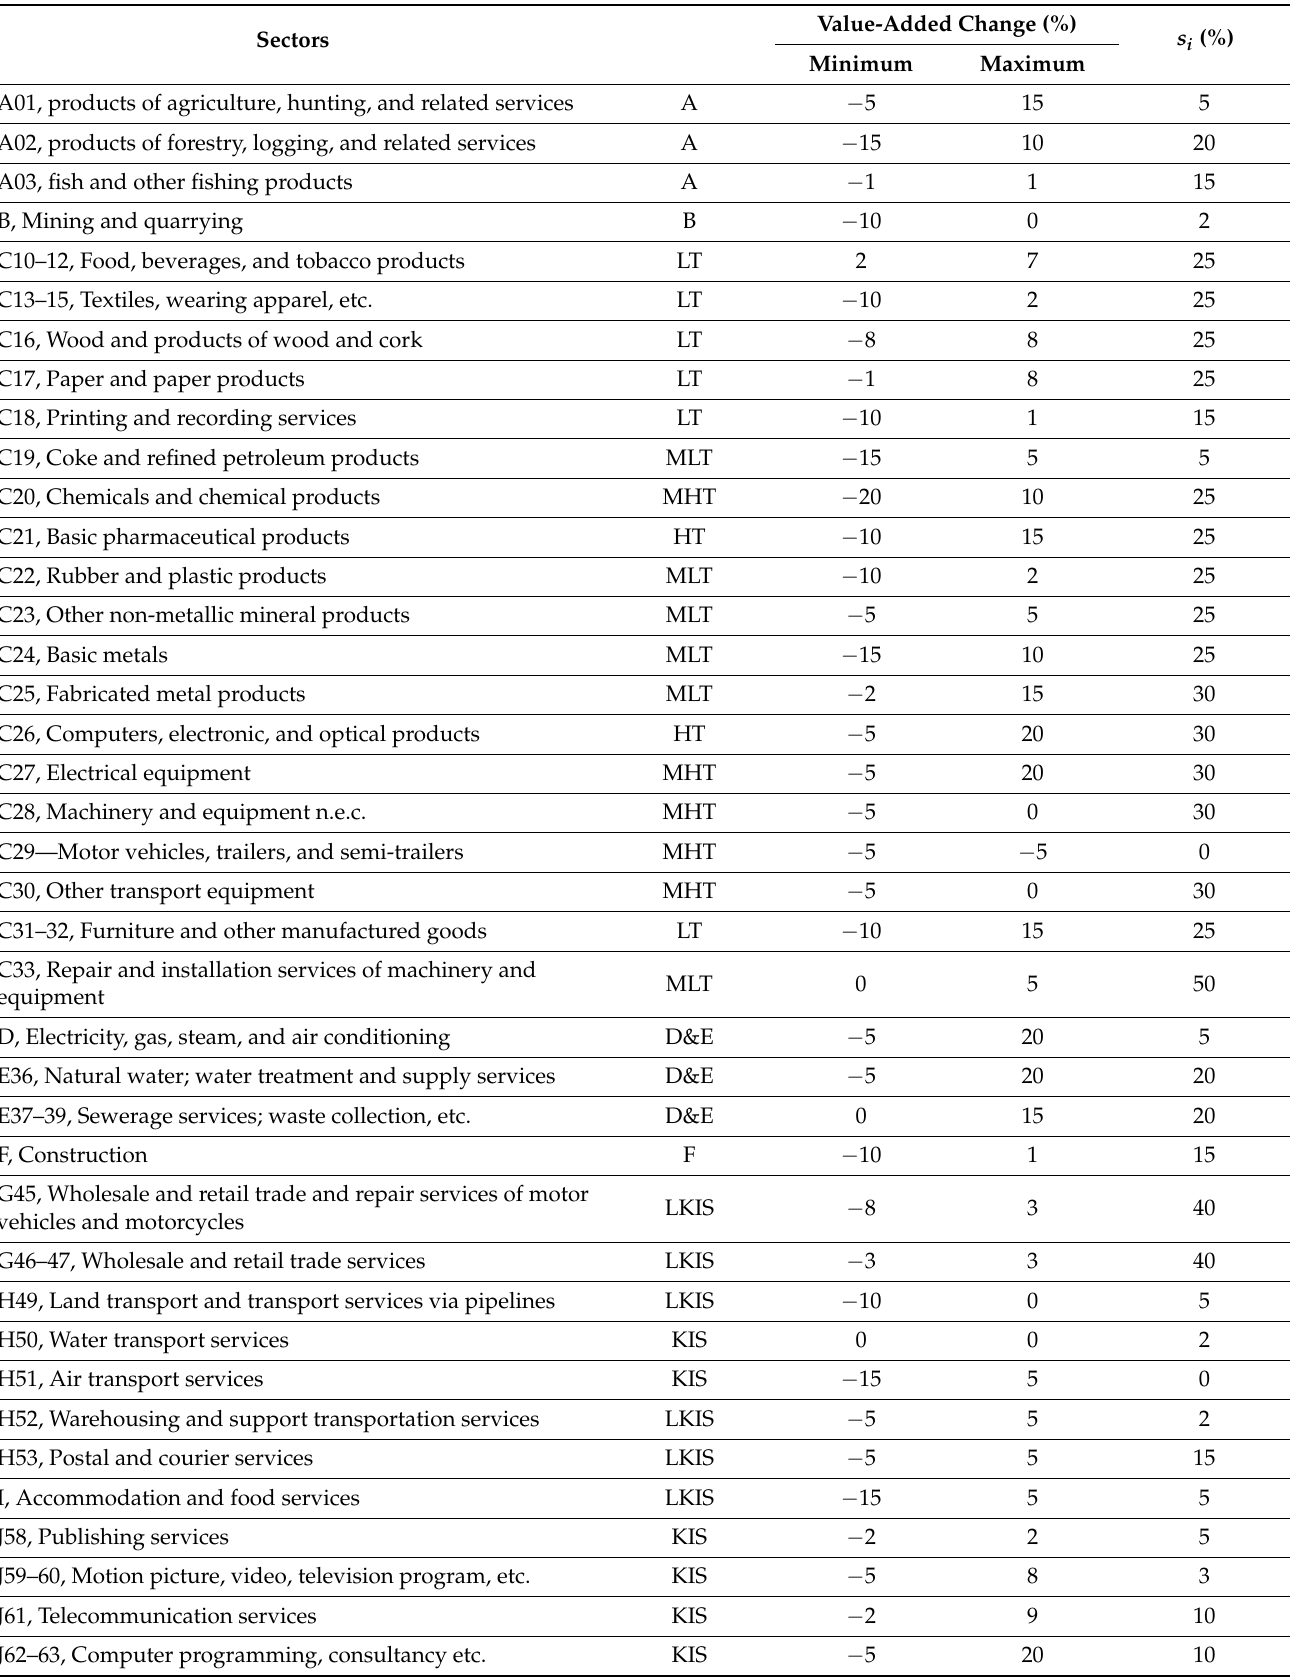
Table 1. Sectoral classification and substitution